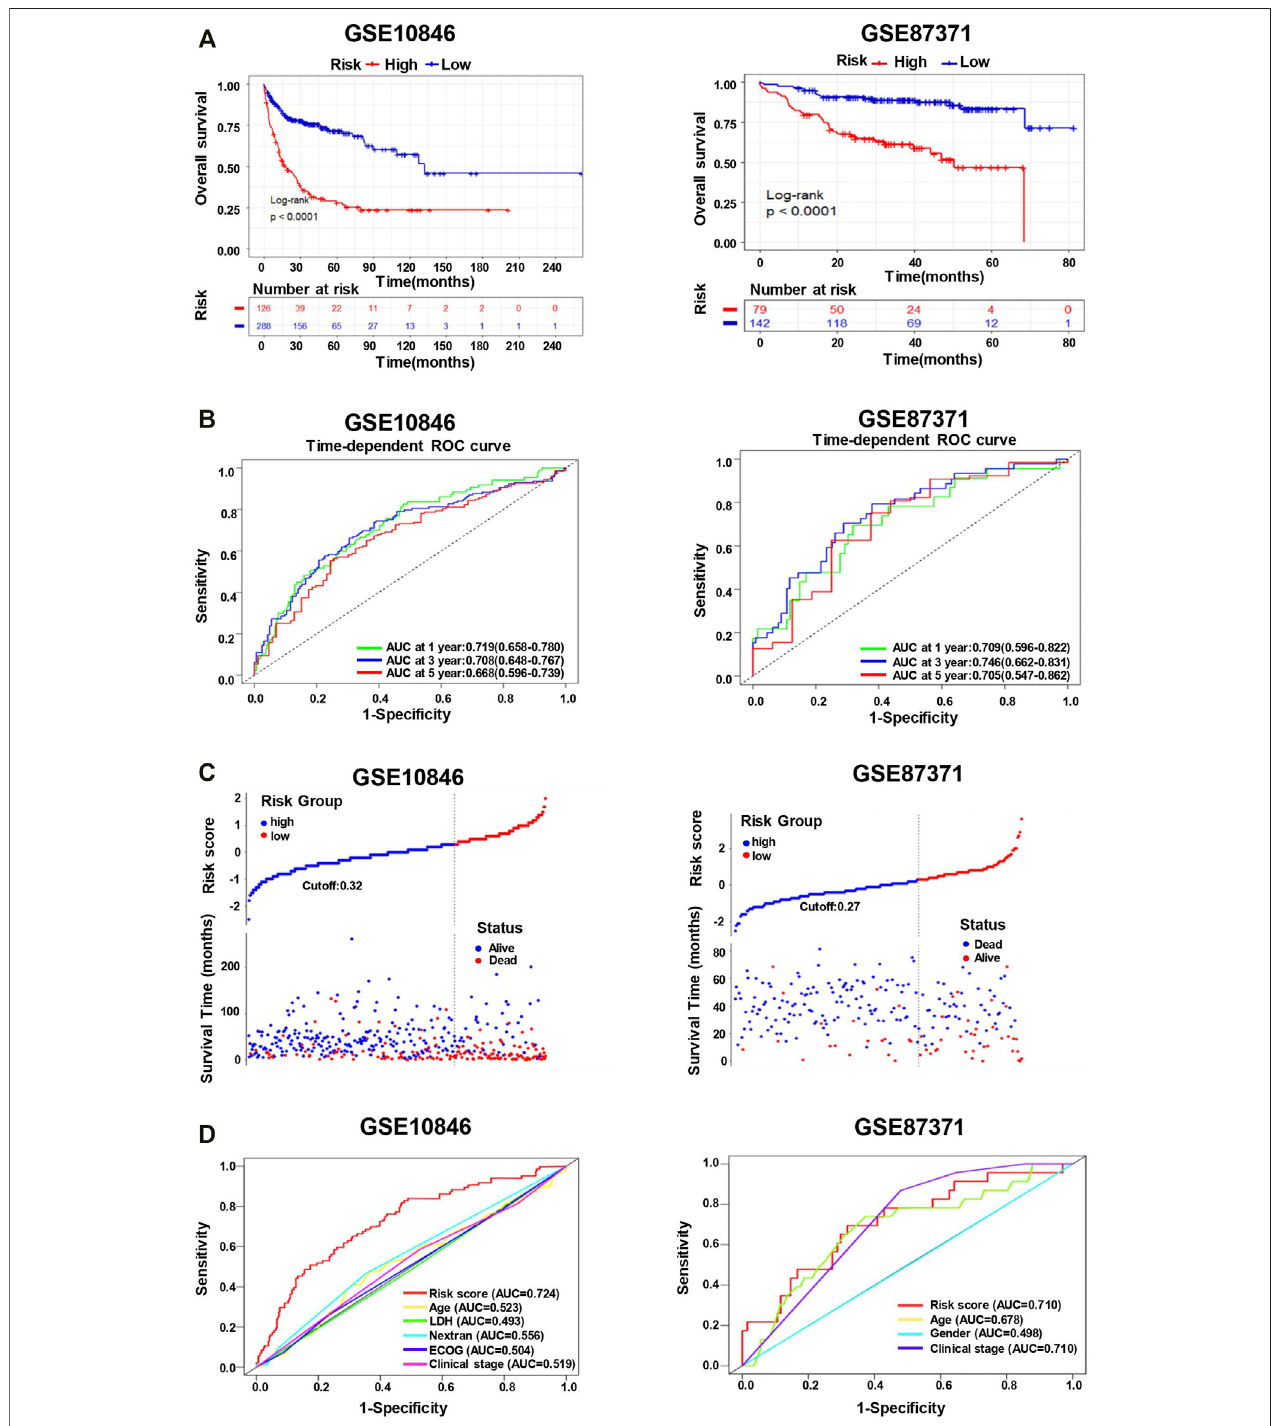
FIGURE6| The11-generiskscoremodelforthevalidationdatasets(GSE10846andGSE87371). (A) Kaplan – Meierplotsofoverallsurvivalinhigh-riskandlow-risk subgroupsinthevalidationdatasetsderived via Log-ranktesting. (B) Thetime-dependentROCcurveandAUCinthevalidationdatasets. (C) Thesurvivalstatusandtime in high-risk and low-risk groups for the validation datasets. (D) The ROC curves to predict the sensitivity and speci fi city of clinicopathological factors and 11-gene signature-derived risk scores in DLBCL patients for the validation datasets.